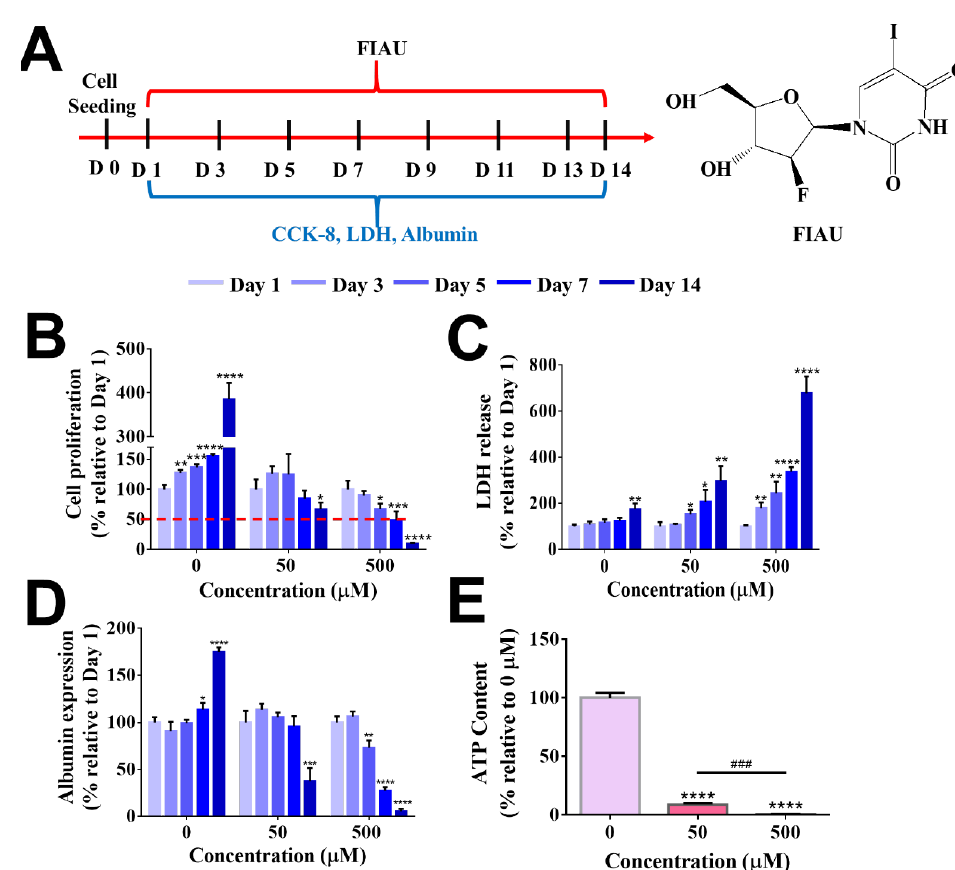
Figure 10. Evaluation of FIAU-induced cytotoxicity in B5-CF scaffolds at day 1, day 3, day 5, day 7, and day 14. ( A ) Experimental timeline for the drug administration. ( B ) Cell proliferation. ( C ) Cytotoxicity (LDH release). ( D ) Albumin expression was assessed at different time points after FIAU treatment ( n = 3, *: p < 0.05, **: p < 0.01, ***: p < 0.005, ****: p < 0.001), compared to the same cryogel type at day 1. ( E ) Evaluation of FIAU-induced human-specific toxicity, mitochondrial disfunction in B5-CF scaffolds. ATP content in cell-laden B5-CF was assessed at the end of 14 days after FIAU treatment. n = 3, ***: p < 0.005, ****: p < 0.001, compared to the group without FIAU treatment. ###: p < 0.005, between the samples at the extremities of the line. The red dashed line indicates the 50% relative cell proliferation.